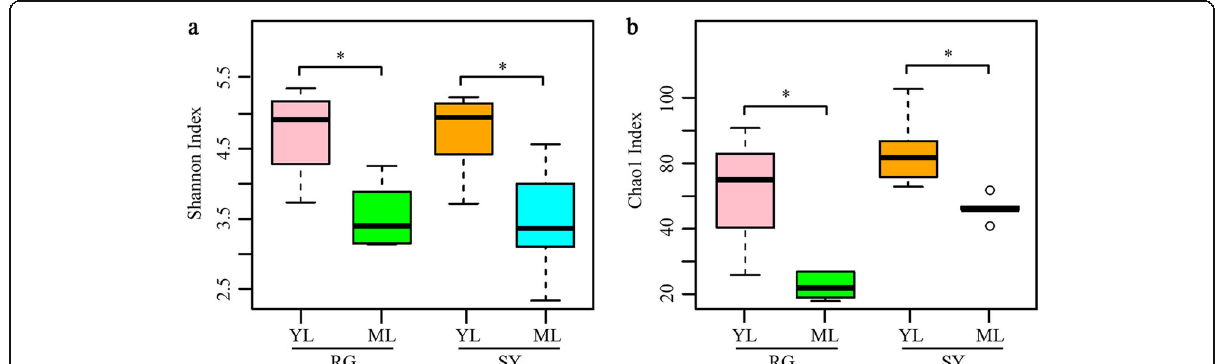
Fig. 3 Endophytic fungal diversity across foliar ages collected from V . vinifera cv. Red Globe and V . amurensis cv. Shuangyou. Four independent samples were used to calculate the values for richness based on Shannon index ( a ) and Chaol index ( b ). Asterisks indicate statistically significant differences ( P < 0.05). RG, V . vinifera cv. Red Globe; SY, V . amurensis cv. Shuangyou; YL, young leaves; ML, mature leaves